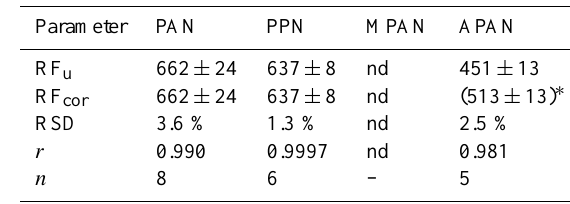
Table 6. Response factors (in mVsppbv − 1 ) of the PAN-GC for PAN, PPN, MPAN and APAN, determined after the FOSSILS cam- paign. Abbreviations are as in Table